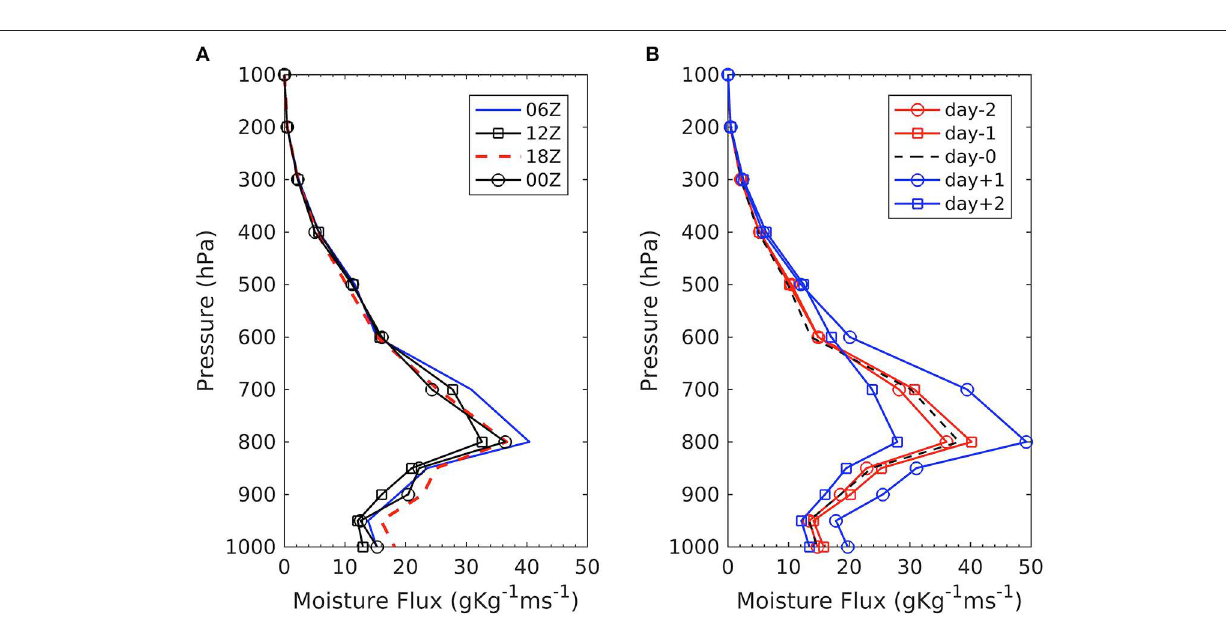
well-developed convection to the east over the low topography of the Amazon is consistent with the position of the front and the spatial distribution of precipitable water (PW) west of 60 ◦ W in Figure 5 . Orographic convection initiation takes place at